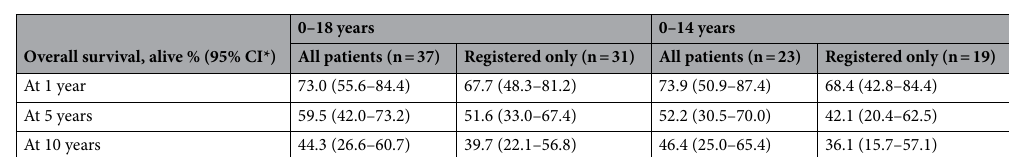
Table 2. Survival estimates at 1-year, 5-years and 10-years for children diagnosed with a VRT at the age of 0–14 and 0–18 years: the impact of the registration completeness on the calculated rates. The estimates